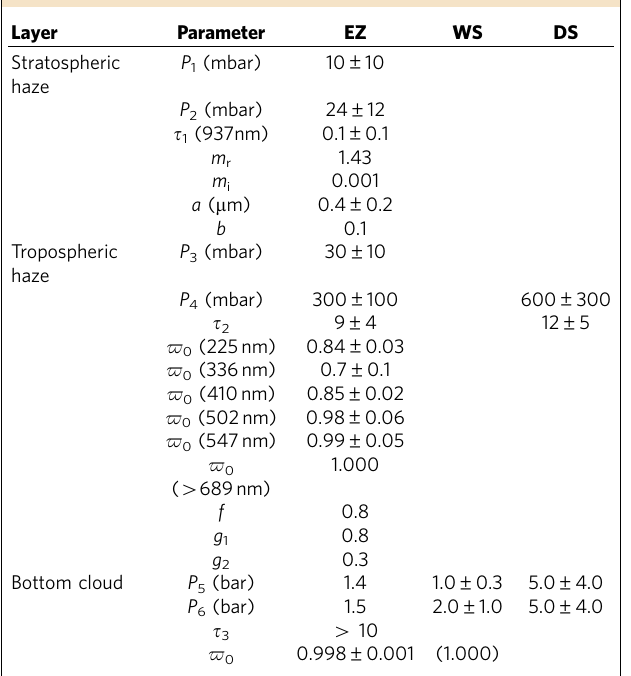
Table 2 | Cloud altitudes from radiative transfer modelling.